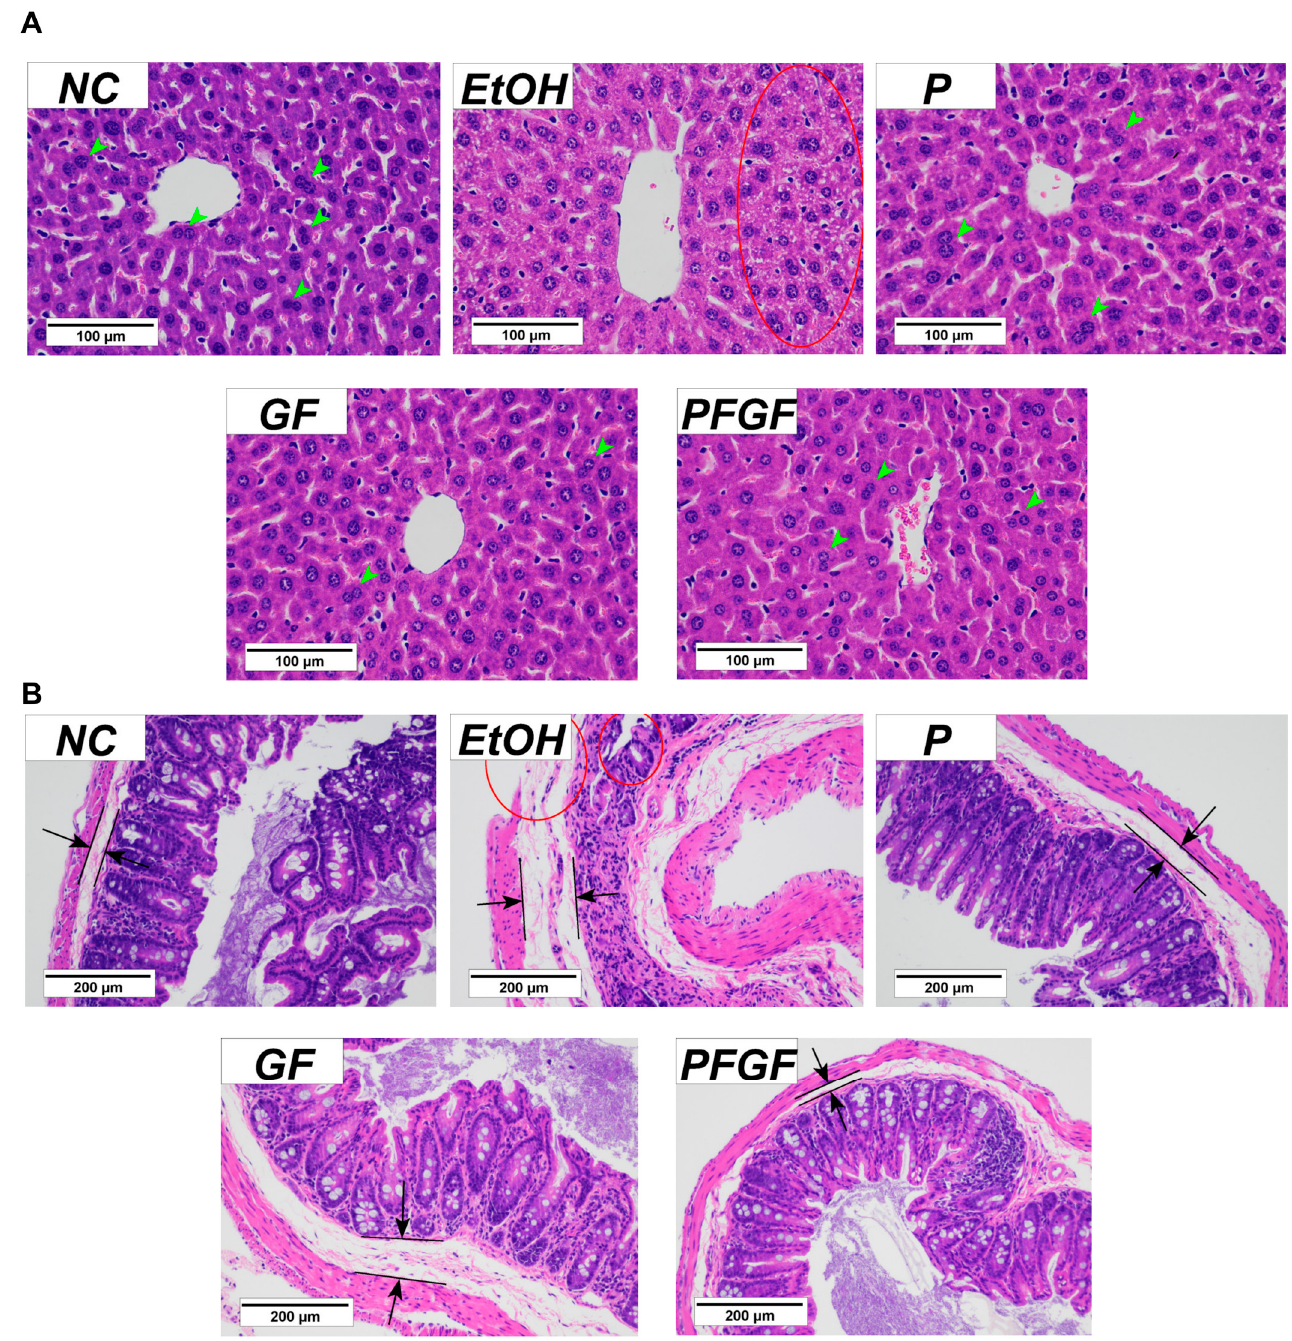
Figure 3. Results of histopathological analysis of liver ( A ) and cecal ( B ) tissues in different groups with hematoxylin and eosin staining at 400× and 200× magnification, respectively. Histopathologic characteristics are marked in the figure. Binucleate cells are marked by green arrows, lipid layer is marked by black arrows and tissue damage is marked by red circle.